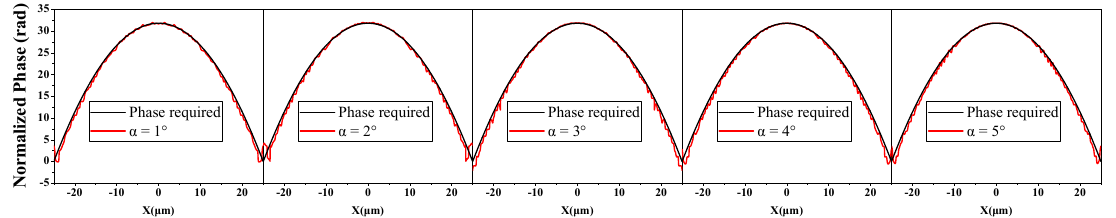
Figure 10. The required phase profile (black curve) and the computed phase profile of the metalenses (red curve) with different values of α after using the MTD method.